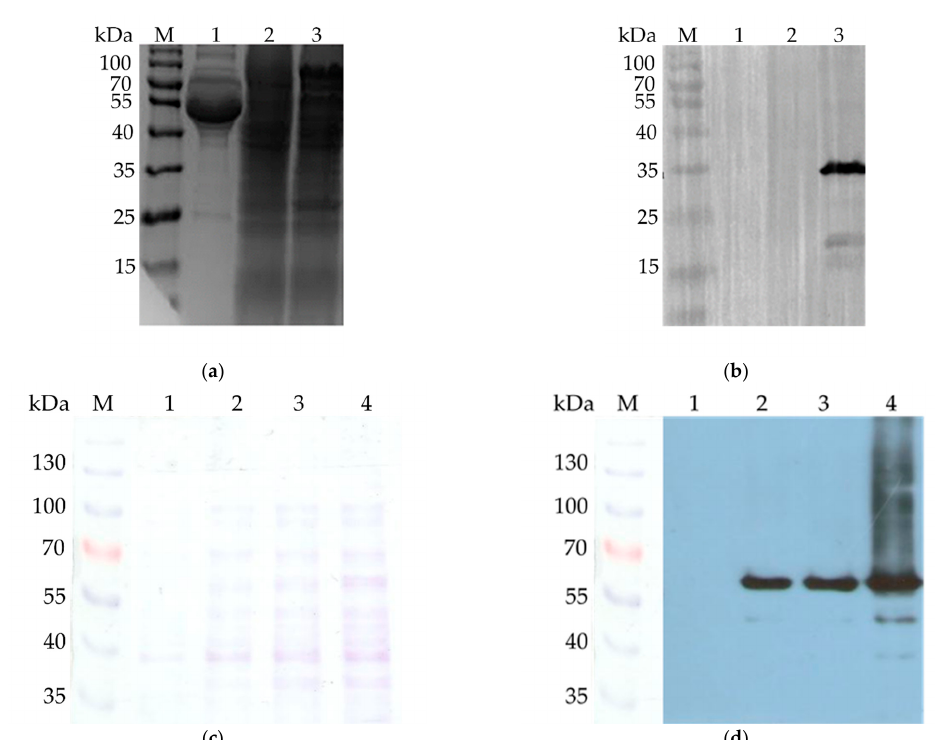
Figure 1. Prokaryotic and mammalian cell expression of PiCV capsid protein. ( a ) SDS-PAGE analysis of PiCV rCap-virus- like particle (VLP) expression in HEK-293 cells. Lane M shows the protein marker (10–170 kDa). Lanes 1, 2, and 3 show the visualized proteins isolated from the culture medium of the transfected cell, cell lysates of the nontransfected and transfected cells, respectively. ( b ) Western blotting analysis of the protein samples using mouse anti-His antibody and horseradish peroxidase (HRP)-conjugated rabbit anti-mouse IgG. Lanes contain similar samples as ( a ). ( c ) SDS-PAGE anal- ysis of PiCV rCap expression in E. coli cells. Lane M shows the protein marker (10–170 kDa). Lanes 1, 2, 3, and 4 show the visualized proteins isolated from the lysate of non-Isopropyl β -D-1-thiogalactopyranoside (IPTG)-induced cells, and ly- sates of 1 h-, 2 h- and 3 h-IPTG-induced cells, respectively. ( d ) Western blotting analysis of the protein samples using mouse anti-His antibody and horseradish peroxidase (HRP)-conjugated rabbit anti-mouse IgG. Lanes contain similar sam- ples as ( c ).